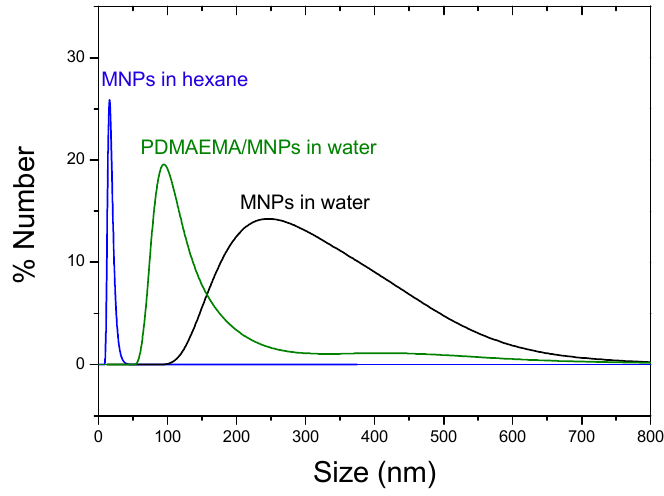
Figure 2. Particle size distributions by number of Fe 3 O 4 nanoparticles in the indicated conditions.